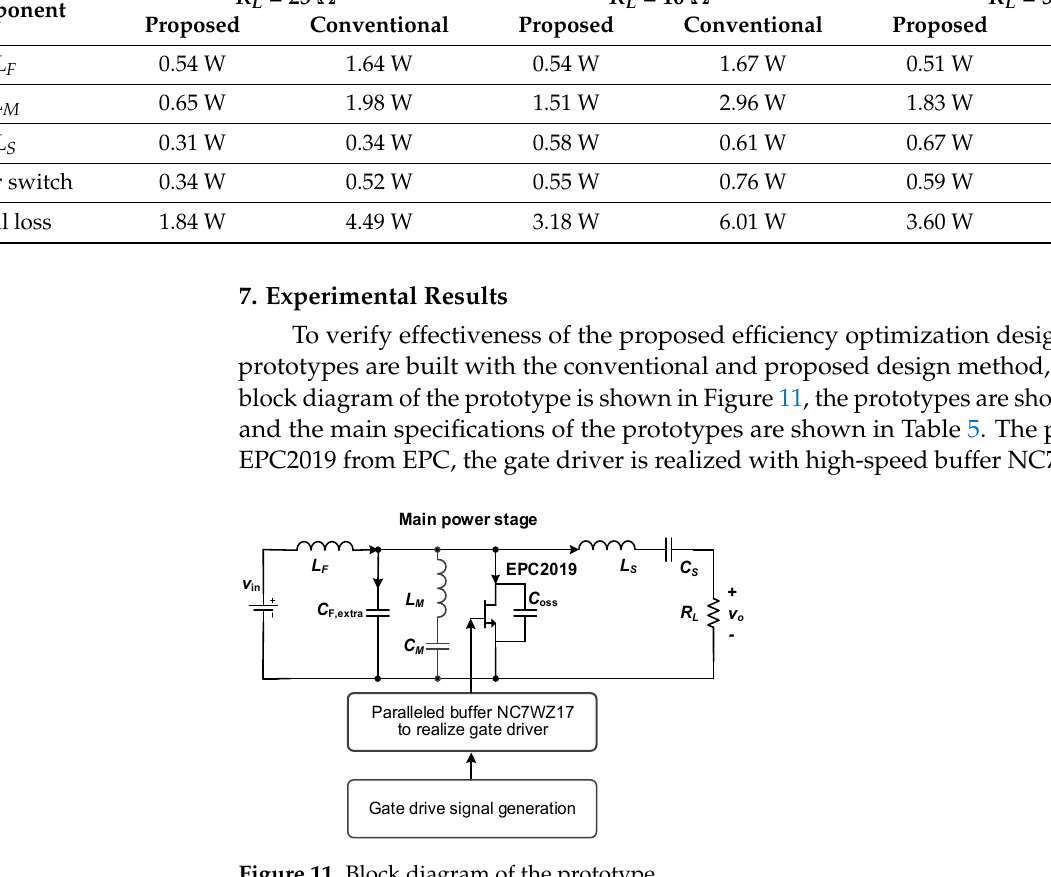
Table 4. Component losses of the class Ф 2 inverter.